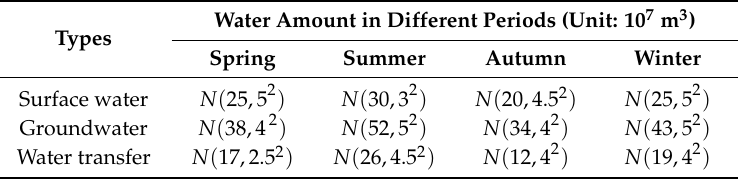
Table 3. The obtainable water resources in four planning periods.